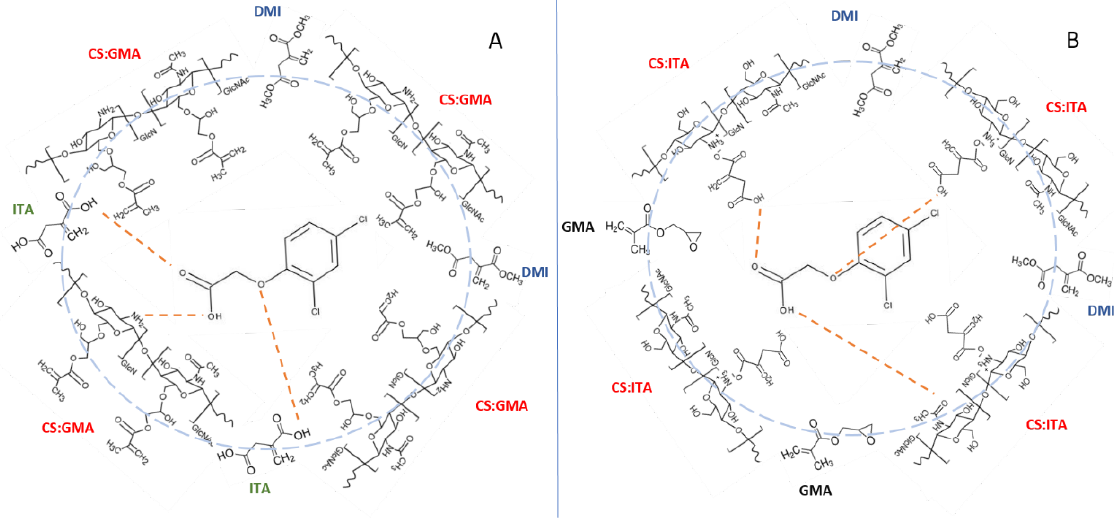
Figure 6. Interactions among the pesticide and MIP components for CS_GMA ( A ) and CS_ITA ( B )